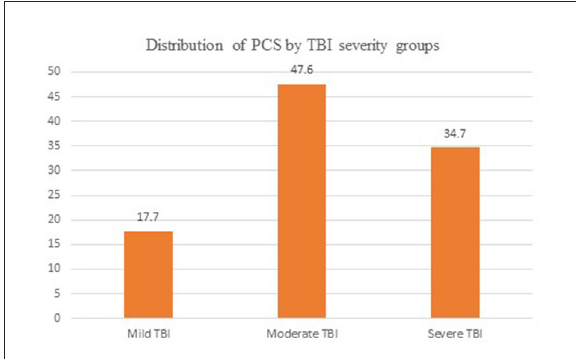
FIGURE1 Distributions of PCS by TBI severity groups by percentage. PCS, post-concussion syndrome; TBI, traumatic brain injury.